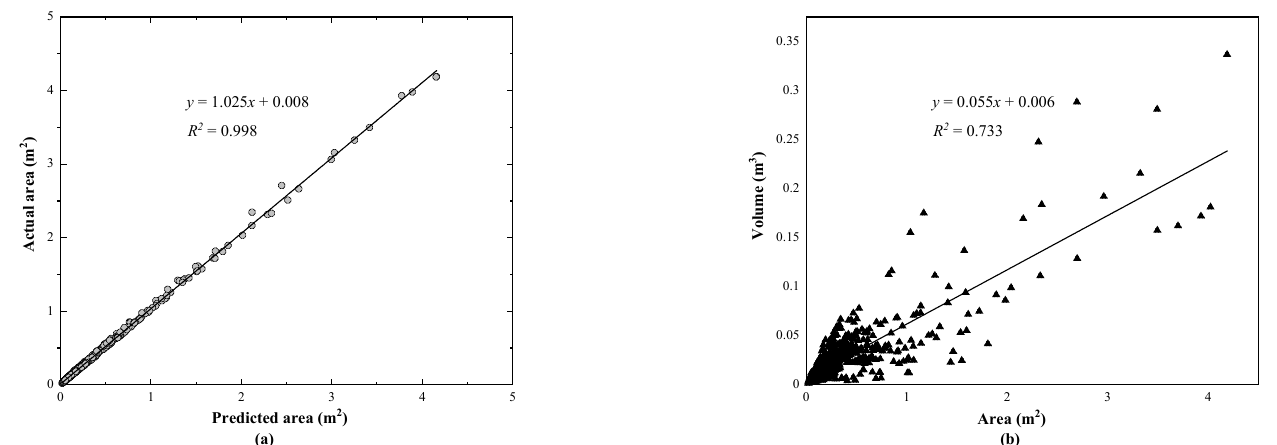
Figure 16. Comparison results of volume calculation from forward and backward measurements.